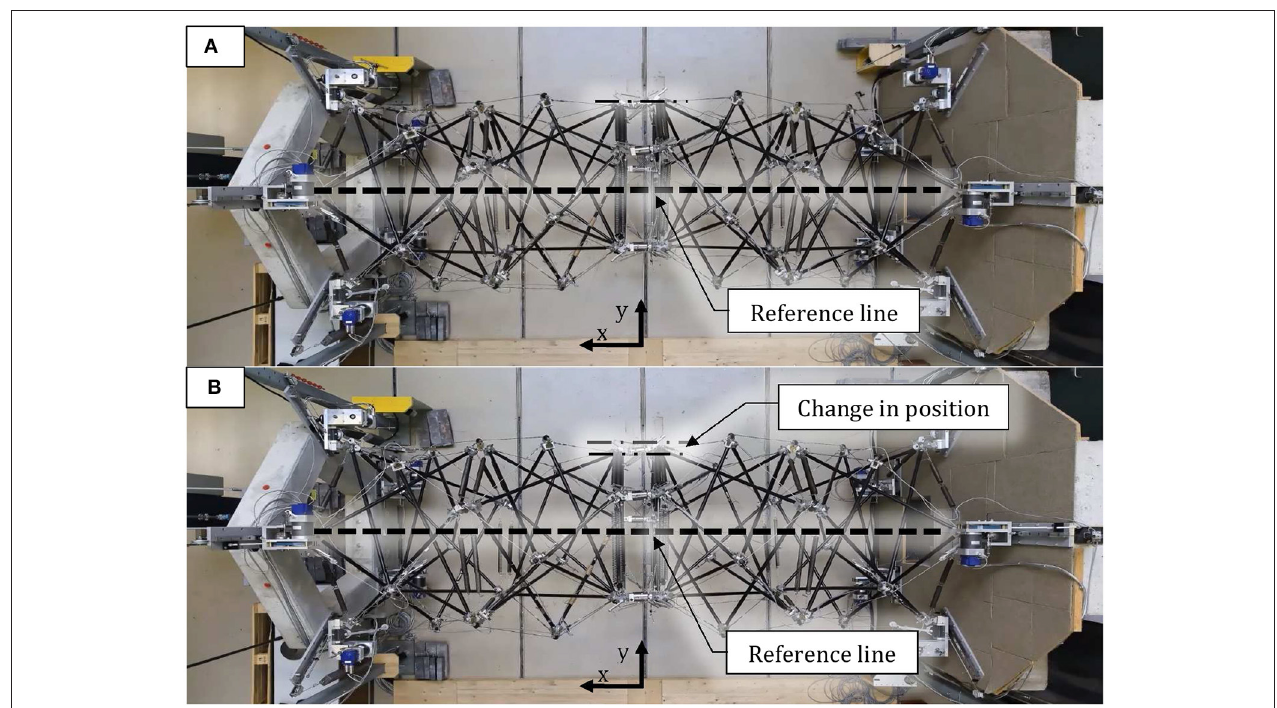
FIGURE 7 | View from above of the tensegrity structure (A) post midspan connection and (B) after an initial self-stress imposed. In (B) , the reference line becomes the center-line of the